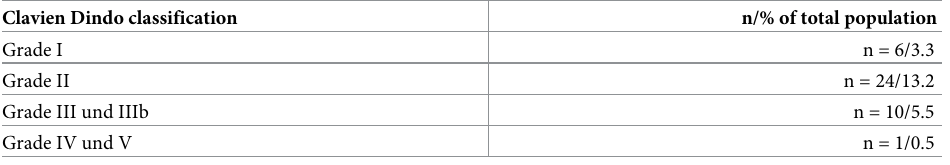
Table 2. Postoperative